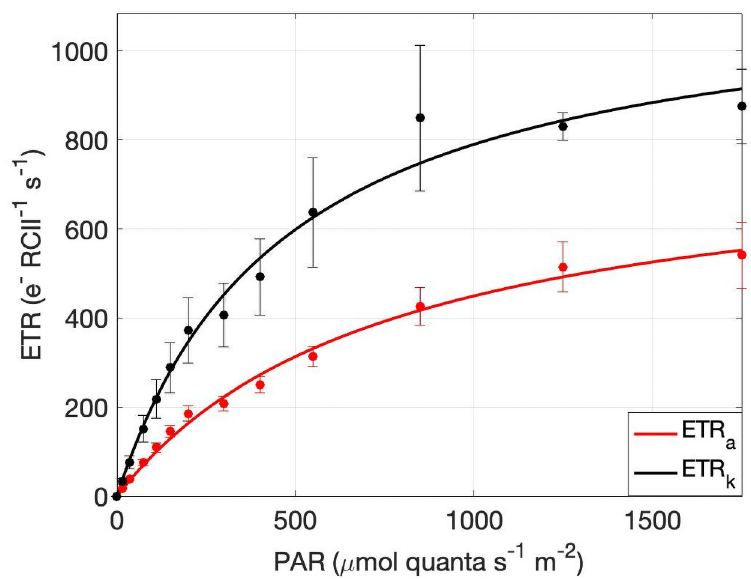
Fig 6. Photosynthesis-irradiance curves derived by ETR a and ETR k . Consolidated mean ETR a (red) and ETR k (black) estimates at each light step of the 25 reprocessed P-I curves. Error bars represent the standard error of all individual measurements from all curves at each light step. Curves were produced using the photosynthesis-irradiance function described by Webb et al. (1974).